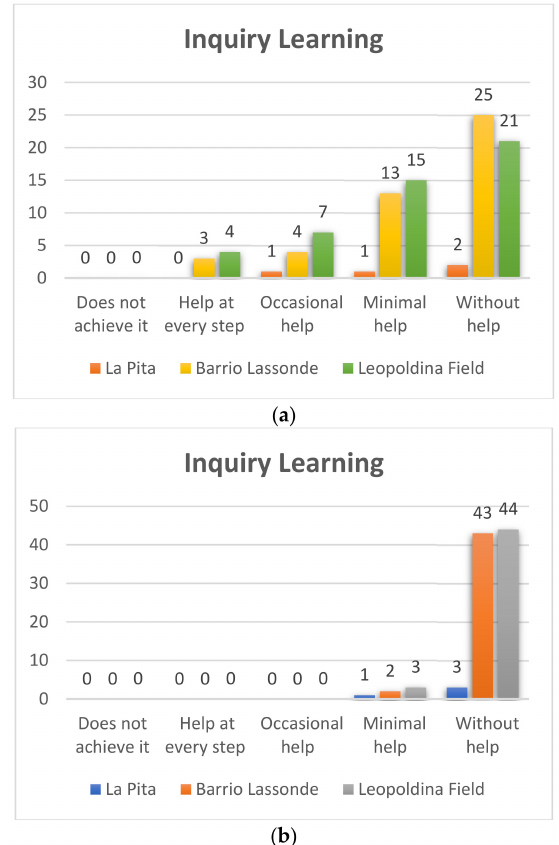
Figure 12. First grade Inquiry Learning Pre-Test ( a ) – Post-Test ( b